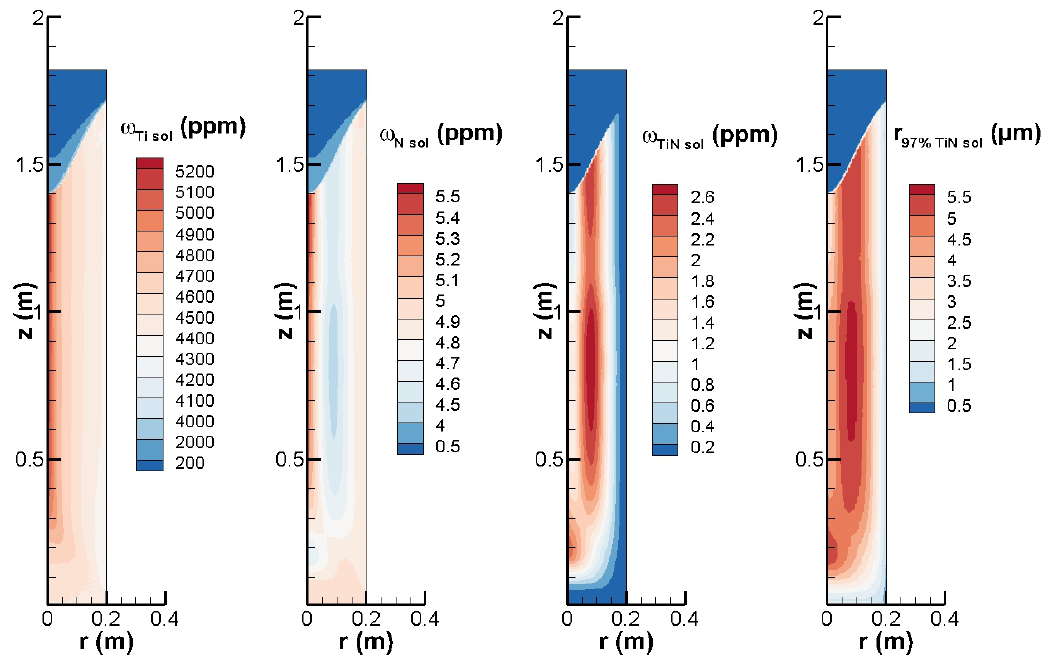
Figure 12. Computed cleanliness of the remelted